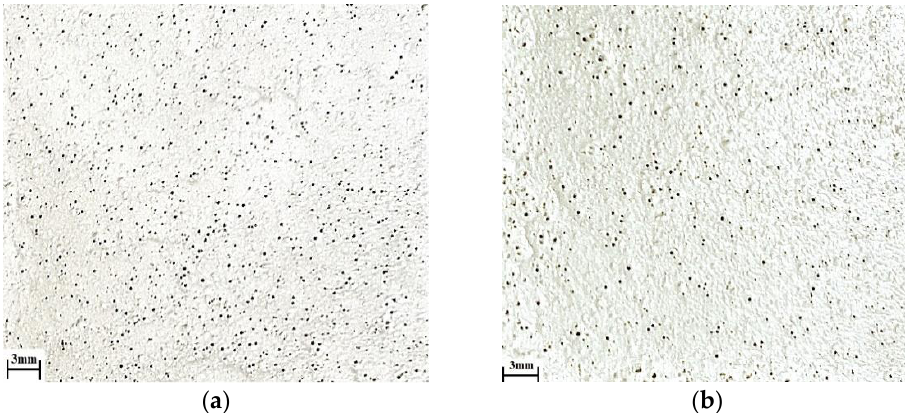
Figure 12. The effect of surfactant content on the appearance of the coating: ( a ) without surfactants; and ( b ) with NaPA 0.25g/dm 3 .